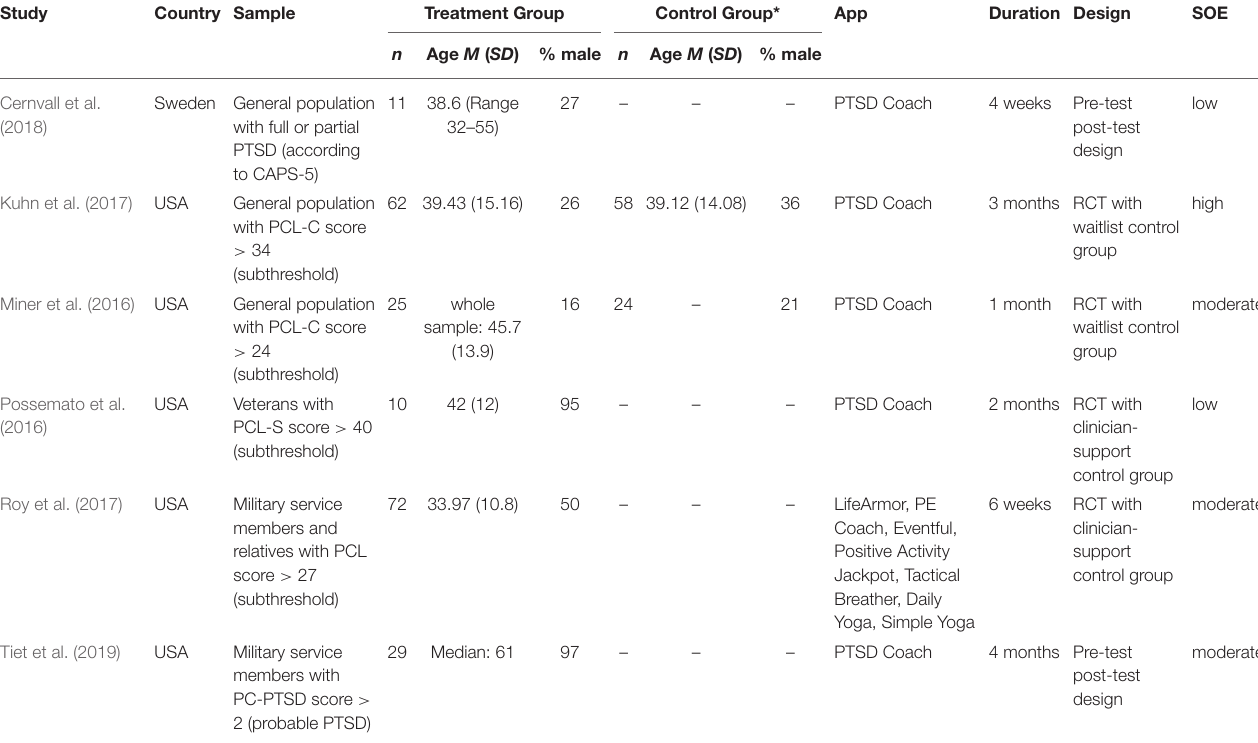
TABLE 1 | Characteristics of the six studies included in the